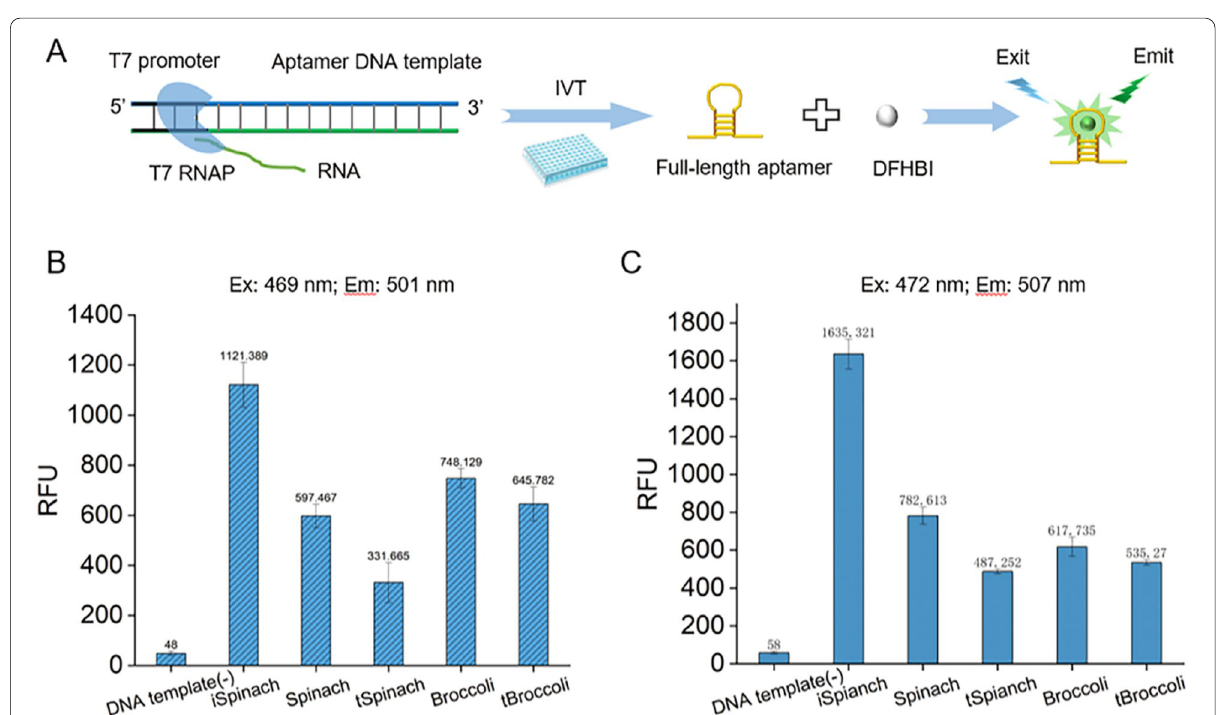
Fig. 1 Screening a fluorescent aptamer suitable for in vitro transcription. A Schematic design of the real‑time fluorescent assay method for monitoring the RNA synthesis. The DNA template contains a T7 promoter and downstream sequence encoding fluorescent RNA aptamer. B The relative fluorescence units (RFU) generated by five different RNA aptamers were measured under the condition that the excitation wavelength (Ex) was 469 nm and the emission wavelength (Em) was 501 nm. C The fluorescence intensities of five different RNA aptamers were measured under the condition that the Ex was 472 nm and the Em was 507 nm. Error bars represent the standard deviation of the triplicate experiments, P < 0.02